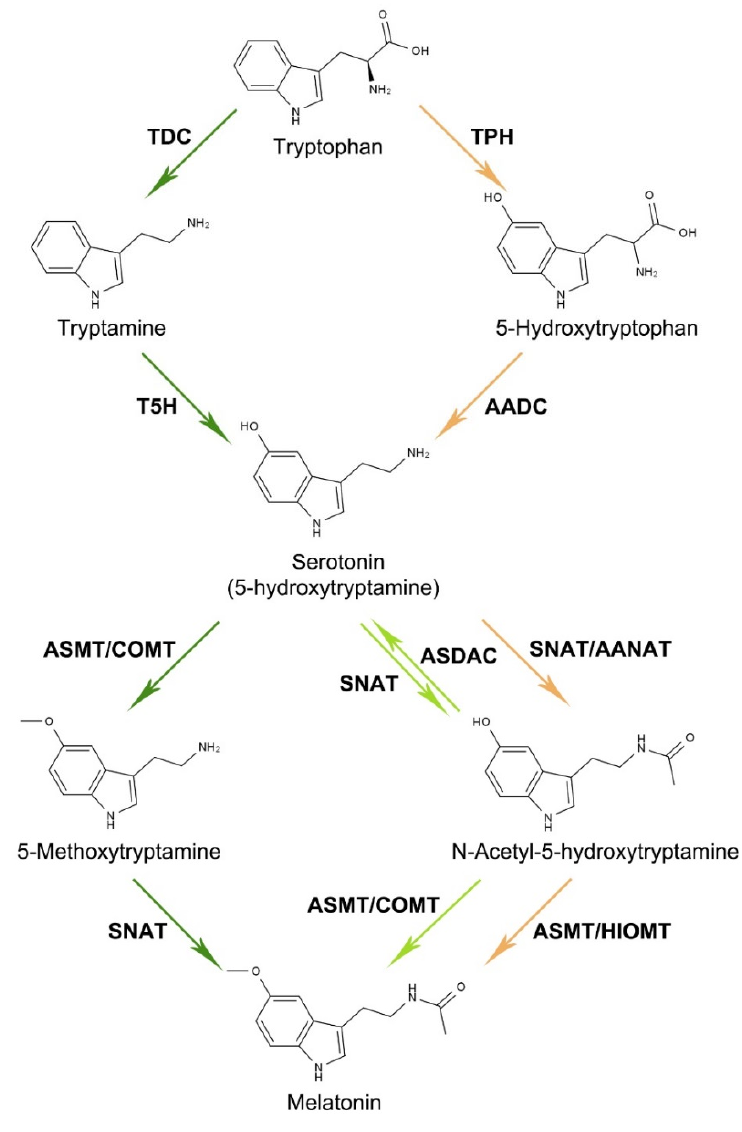
Figure 1. Comparison of the melatonin biosynthesis pathways in animals and plants. The yellow arrows indicate the pathway of animals, while the green arrows indicate the pathway of plants. Plant SNATs are rate-limiting enzymes catalyzing two reactions. The light green arrows indicate a minor pathway, since the SNAT enzymes of most plants tend to accommodate 5-Methoxytryptamine as